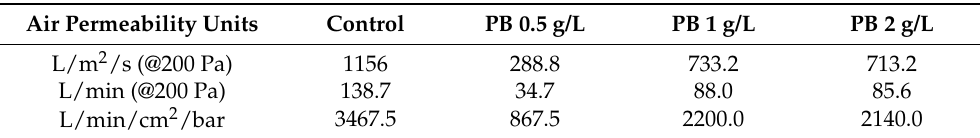
Figure 2. Air permeability measurement of polyester before and after coating with Prussian blue (PB) formulations at different concentrations (0.5 g/L, 1 g/L and 2 g/L), (n = 10, ± SD), **** p < 0.0001 (one-way ANOVA, Š í d á k’s test). The control used is referred to polyester samples without functionalisation. Table 2. Air permeability values of the control polyester before coating and the samples functionalised with Prussian blue (PB) formulations at different concentrations (0.5 g/L, 1 g/L and 2 g/L) converted into different units.